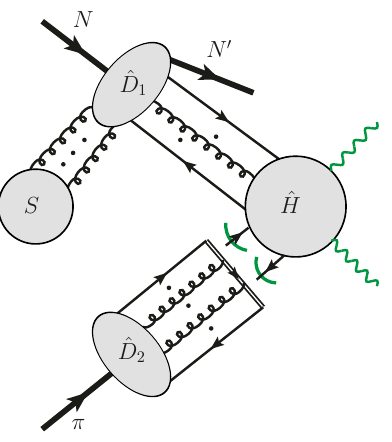
Figure 17. The result of using Ward identity for soft gluons coupling to ˆ D 2 . Those gluons cancel. The Wilson line is along w 1 .